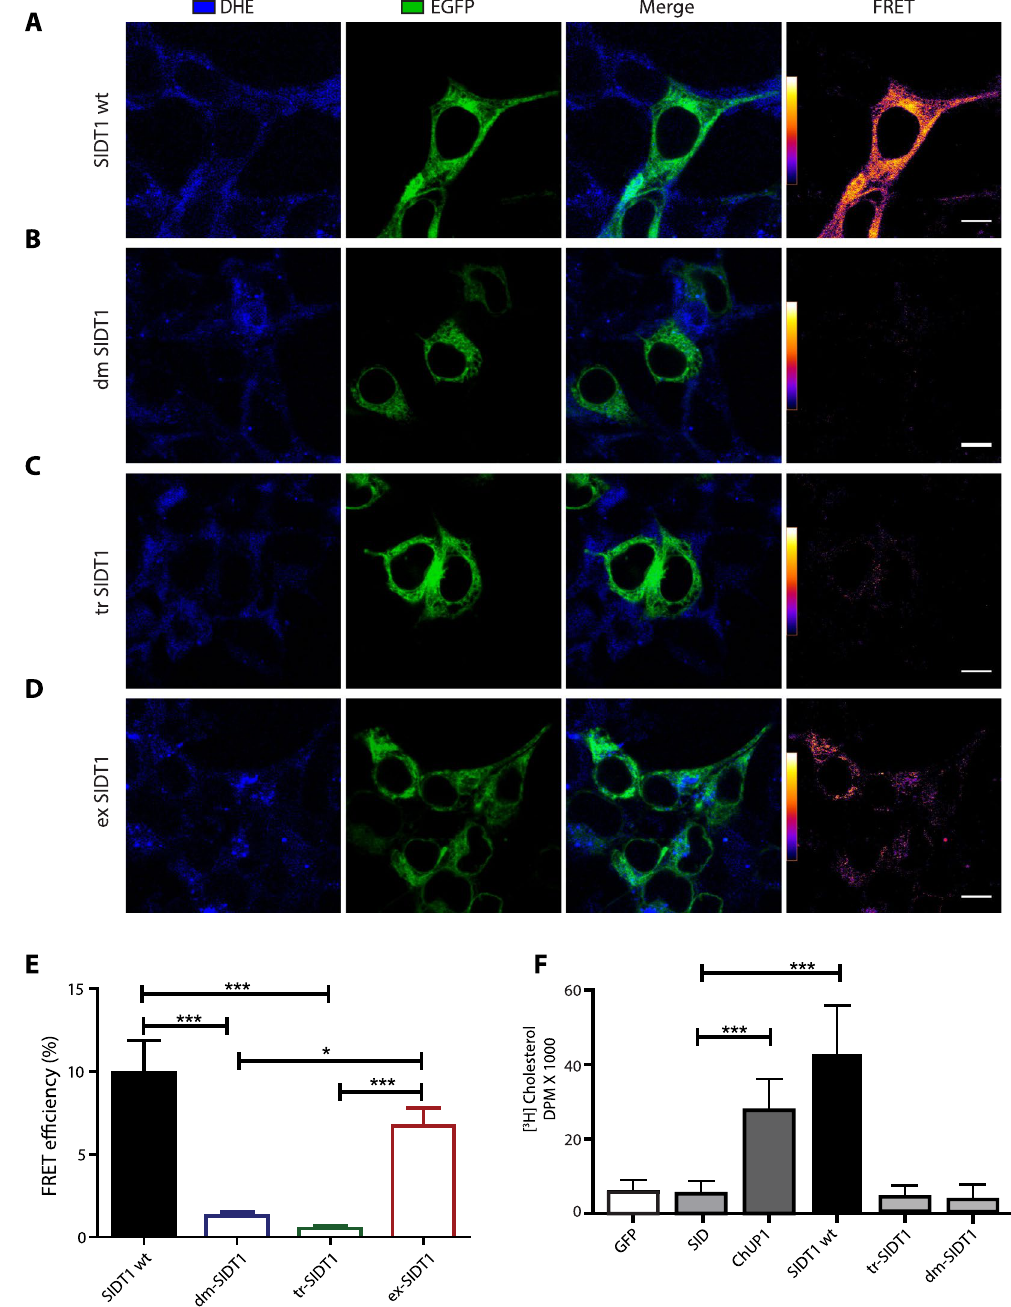
Figure 2. The localization of SIDT1 and cholesterol transport. ( A ) Confocal microscopy representative images illustrating the localization of the SIDT1 wild-type, ( B ) double CRAC domain mutant (dmSIDT1), ( C ) transmembrane CRAC domain (tmSIDT1) and ( D ) extracellular CRAC domain (exSIDT1). All proteins were fused to GFP. In blue is illustrated the fluorescence of dehydroergosterol (DHE). FRET signal was calculated using the sensitized emission method 44, 45 . Scale bar: 10 microns. ( E ) FRET efficiency between GFP and DHE (plotted as percentage). ( F ) [ 3 H]-cholesterol uptake from HEK293 cells expressing the SIDT1 wild type and the three mutants. * p < 0.001; ** p < 0.01; *** p <